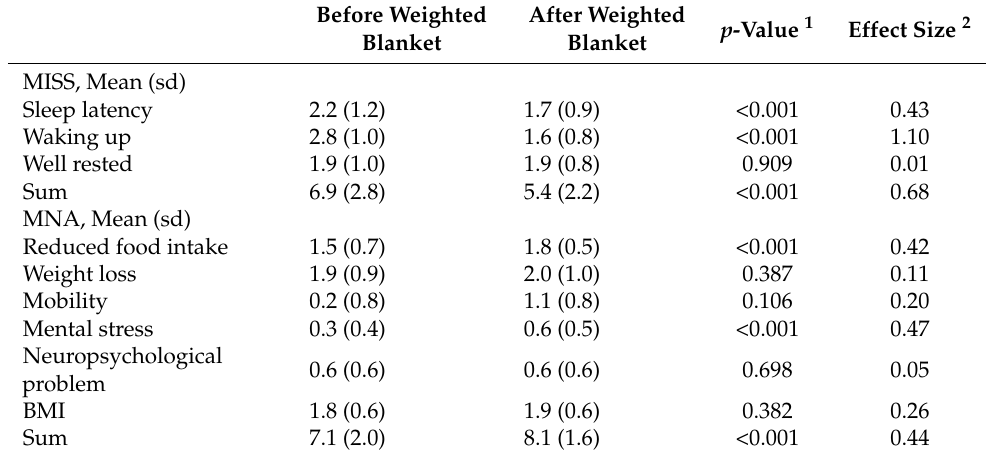
Table 2. MNA before and after utilisation of weighted blanket for 28 days, n =